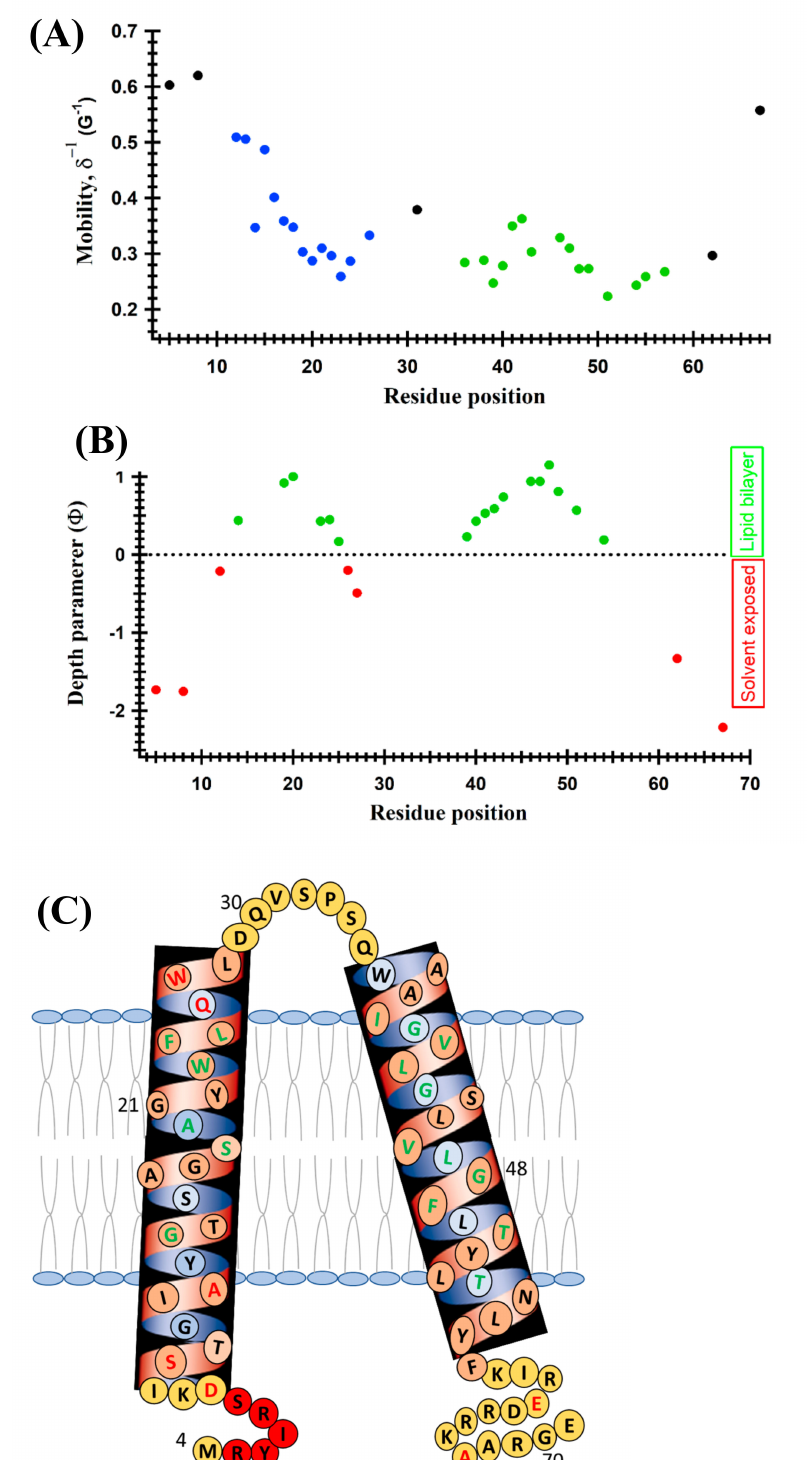
Figure 3. ( A ) The relative mobility of R1 ( δ − 1 ) as a function of residue positions of the primary sequence of S 21 68 IRS . Blue closed circles represent TMD1 residues, green for TMD2, and black indicating loop and terminal regions. ( B ) Membrane depth parameter ( φ ) as a function of the S 21 68 IRS residue positions in DMPC lipid-bilayered vesicles at room temperature. ( C ) The proposed structural topology model of the S 21 68 IRS in DMPC lipid bilayers. (Adapted from [139] with